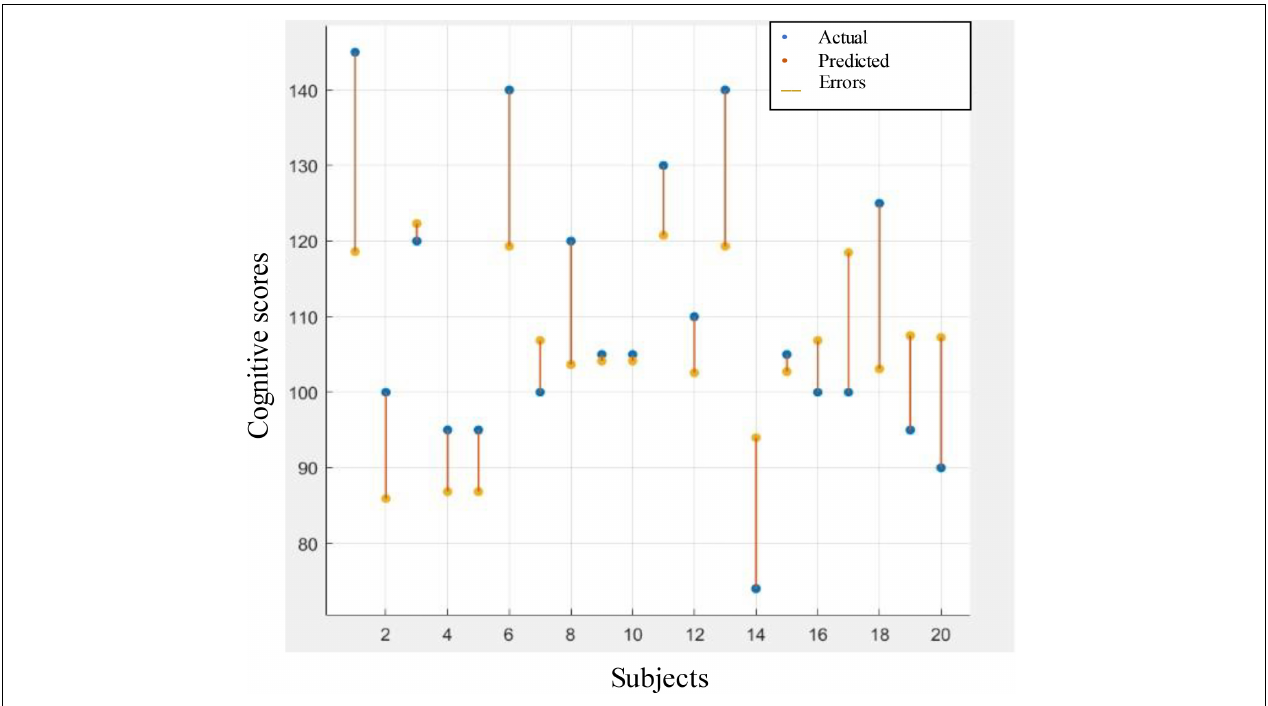
FIGURE 8 | Response plot of predicted cognitive scores versus the actual one. Regression based prediction used the combination of the selected entropies features to predict the cognitive